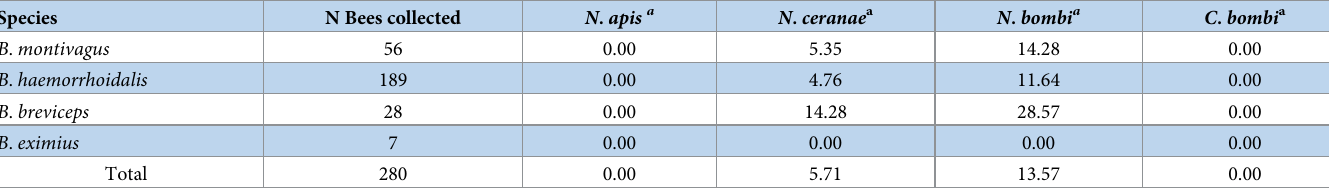
Table 5. Overall occurrence of four parasites in host species ( Bombus spp.) (Identities confirmed from barcodes).